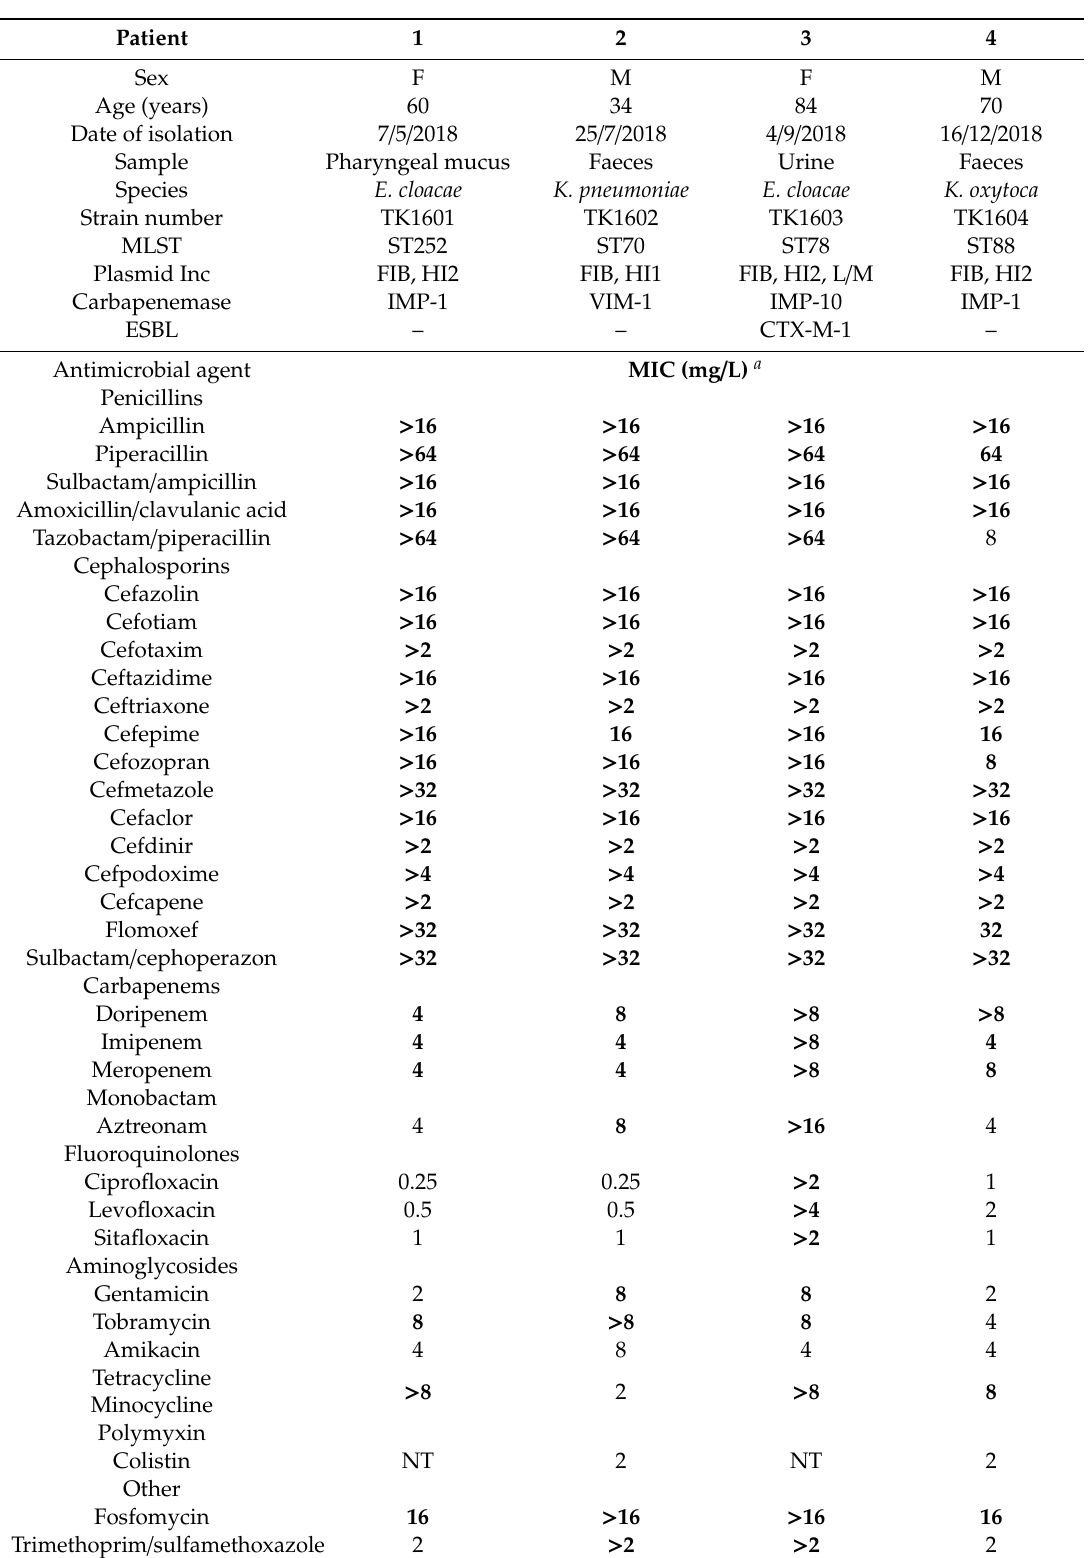
Table 1. Antimicrobial susceptibility profiles of metallo- β -lactamase (MBL)-producing Enterobacteriaceae.